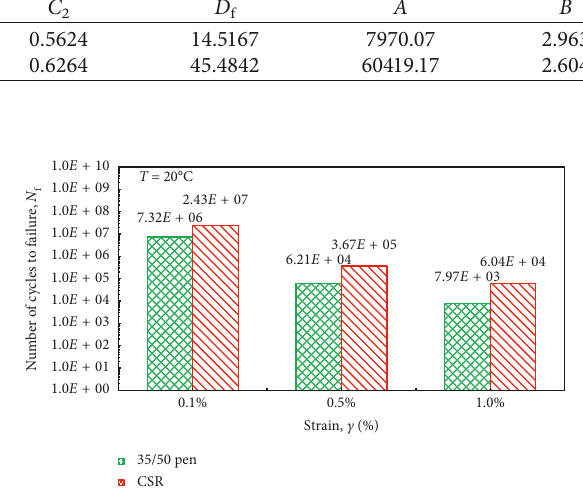
c )—35/50 pen vs. CSR loading f vs. cycles at failure.